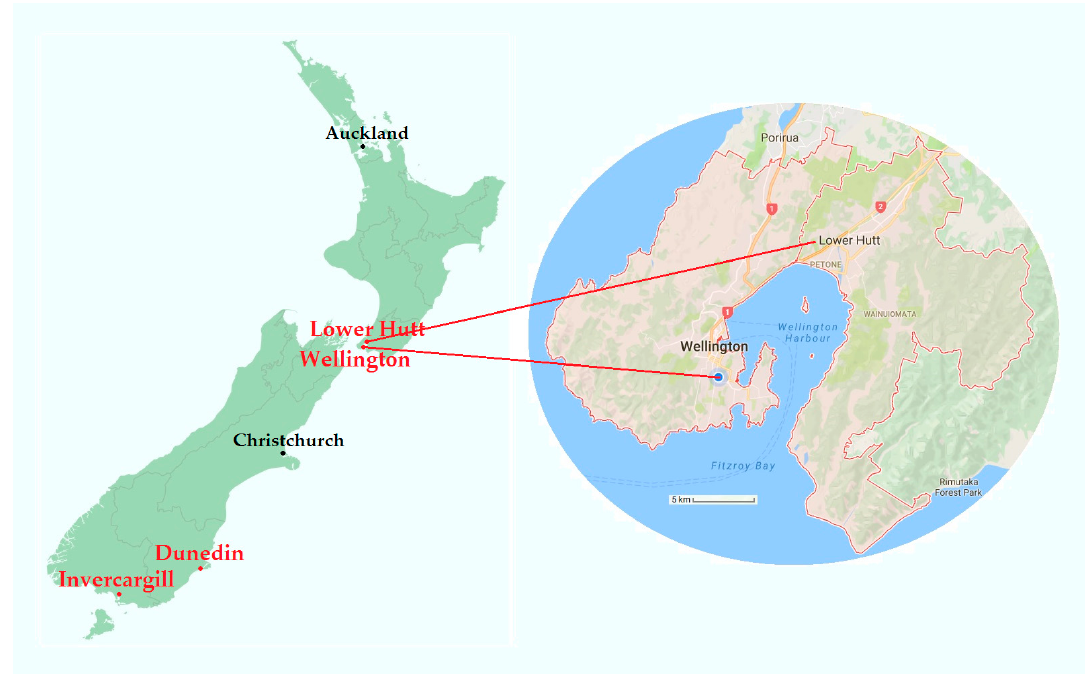
Figure 1. Locations of Wellington, Lower Hutt, Dunedin, and Invercargill. Map attribution: Ozhiker, and Google Maps.